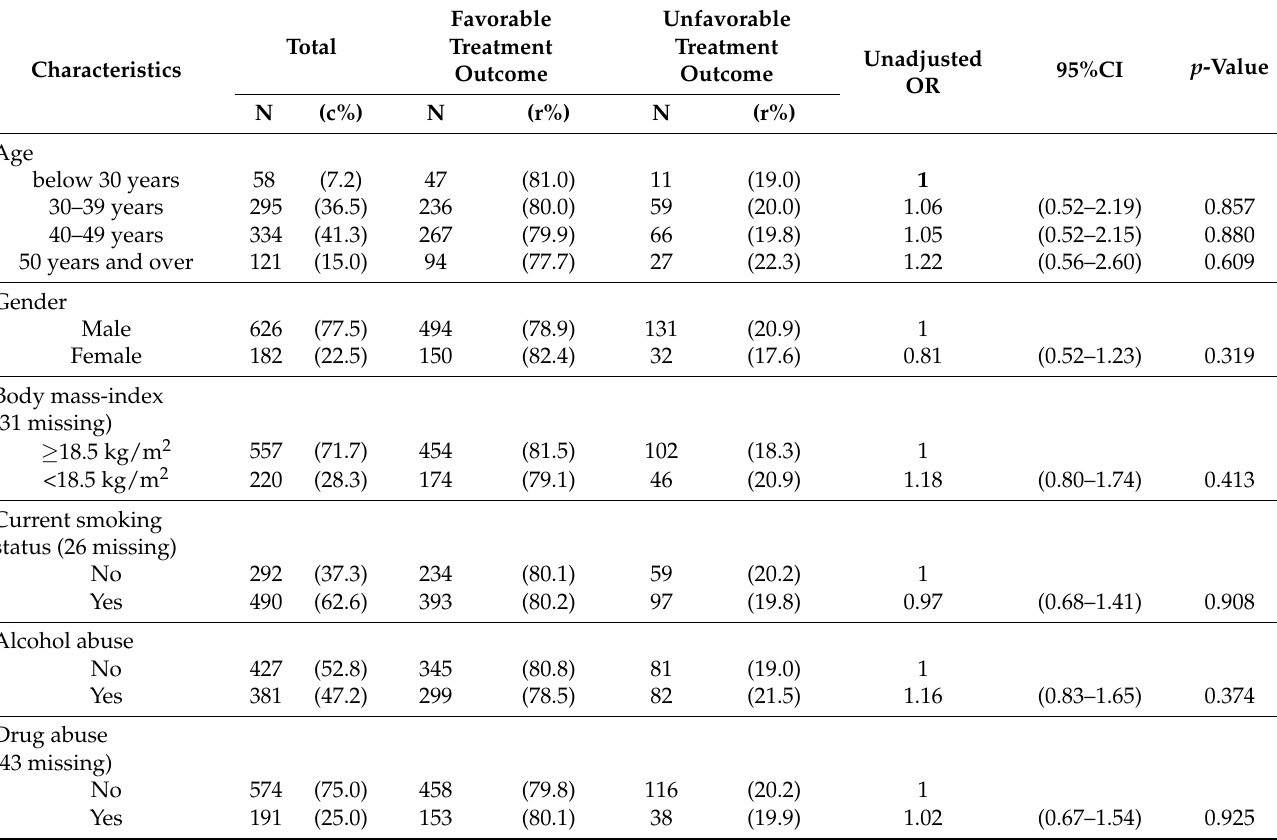
Table 1. Socio-demographic characteristics among human immunodeficiency virus (HIV)-associated tuberculosis (TB) patients registered in Tashkent city, Uzbekistan (2013–2017) and their association with TB treatment outcomes.